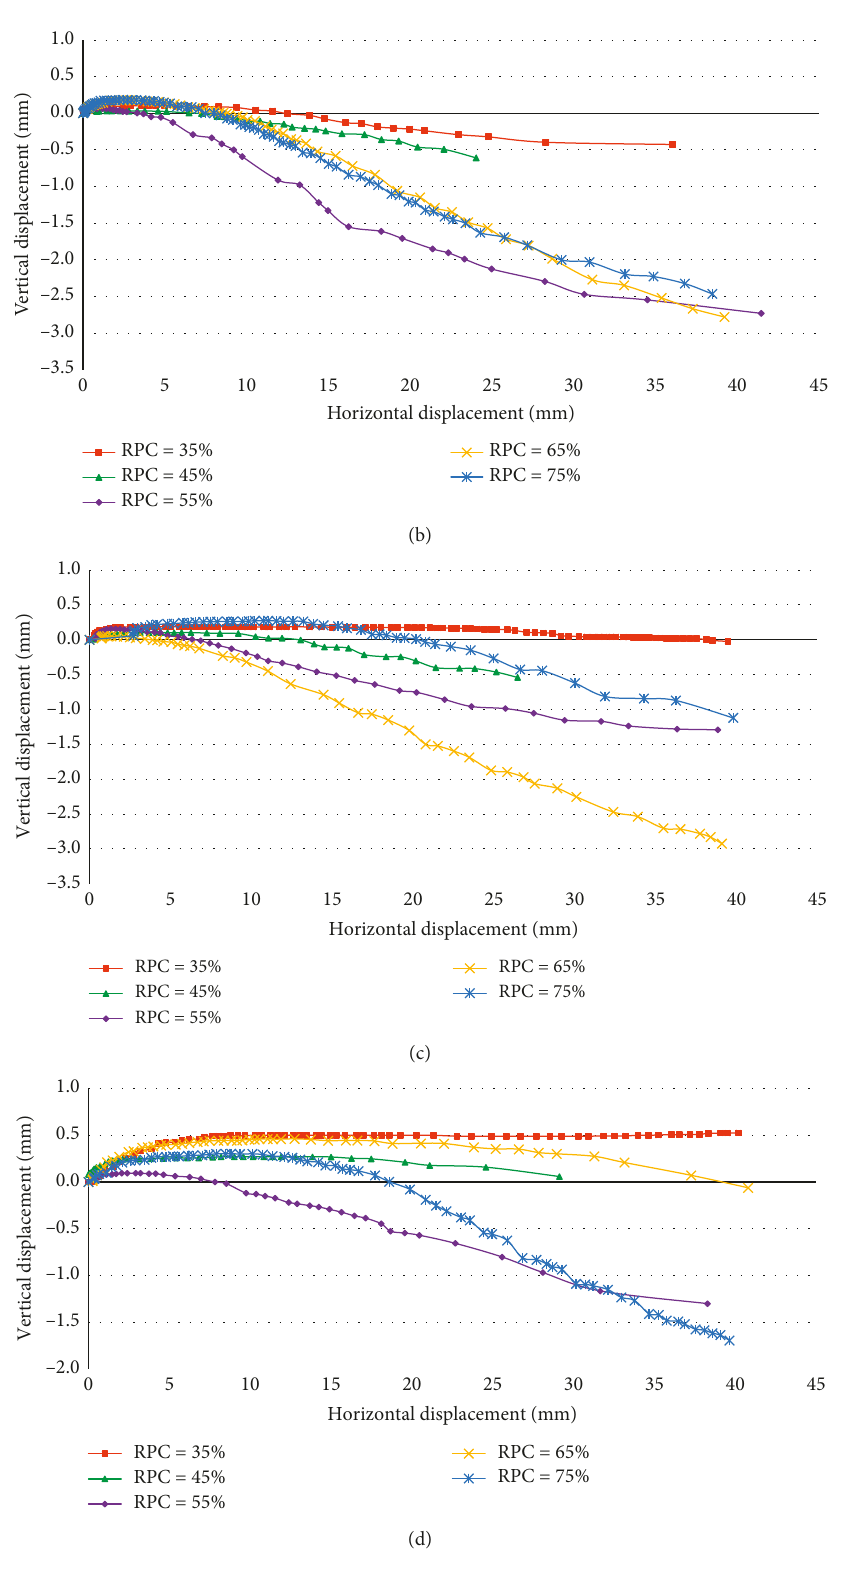
Figure 9: Vertical and horizontal displacement curves of different rock particle content samples under the same normal stresses: (a) normal stress σ n � 141.5 kPa; (b) normal stress σ n � 283.1kPa; (c) normal stress σ n � 424.6kPa; (d) normal stress σ n �